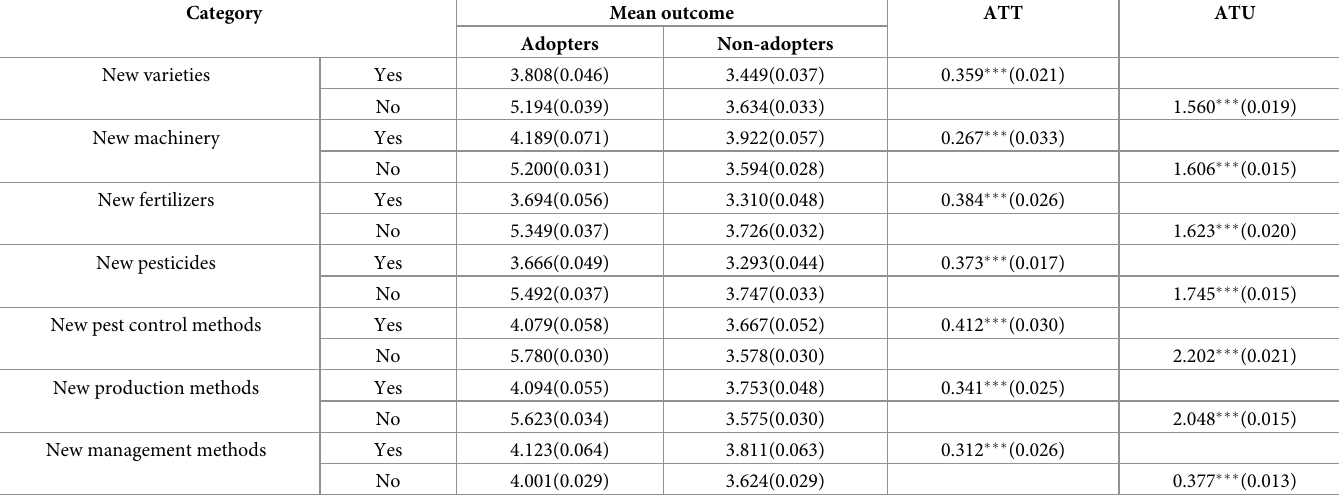
Table 10. Effects of different new agricultural technologies on family farms’ income: Estimates by ESR model.